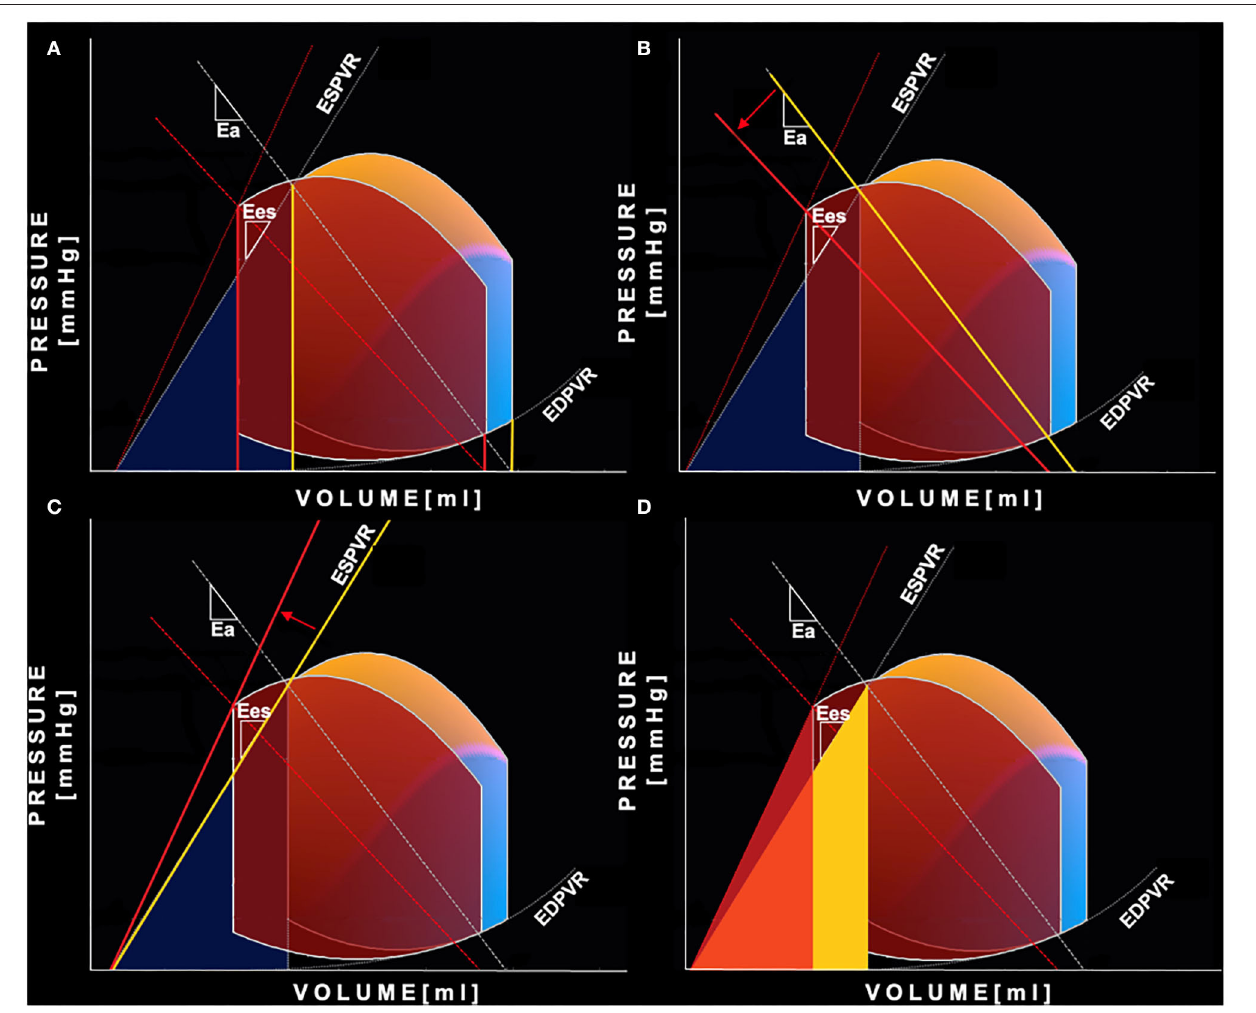
FIGURE 1 | Pressure-Volume curve changes after Sacubitril-Valsartan. Representation of the non-invasive PV loop analysis of a patient before (yellow-blue PV loop) and after 6 months (red PV loop) of therapy with Sacubitril- Valsartan. (A) shows the reduction of both left ventricular end-systolic and end-diastolic volumes (yellow is “before,” red is “after”). The greater relative reduction of the end-systolic volume leads to an increase in stroke volume and ejection fraction. (B) shows decreased left ventricular afterload reflected by a less steep arterial elastance line (yellow is “before,” red is “after”); (C) shows increased end-systolic left ventricular elastance—steeper end-systolic pressure volume relation (yellow is “before,” red is “after”); (D) shows reduction of mechanical potential energy: the light yellow area is the PE before the therapy, the red is PE after the therapy. In orange is displayed the area of overlap between the aforementioned areas. PE, potential energy; PV loop, pressure-volume